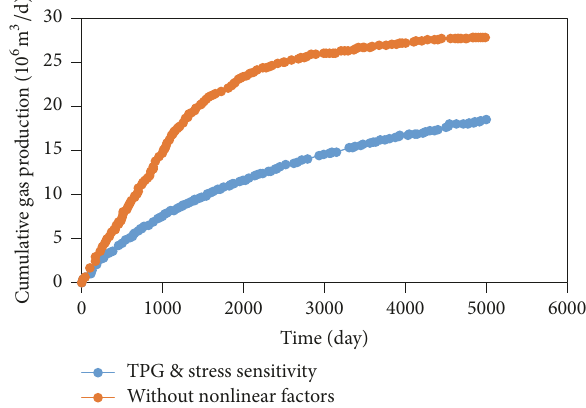
Figure 14: Effect of nonlinear factors on cumulative gas